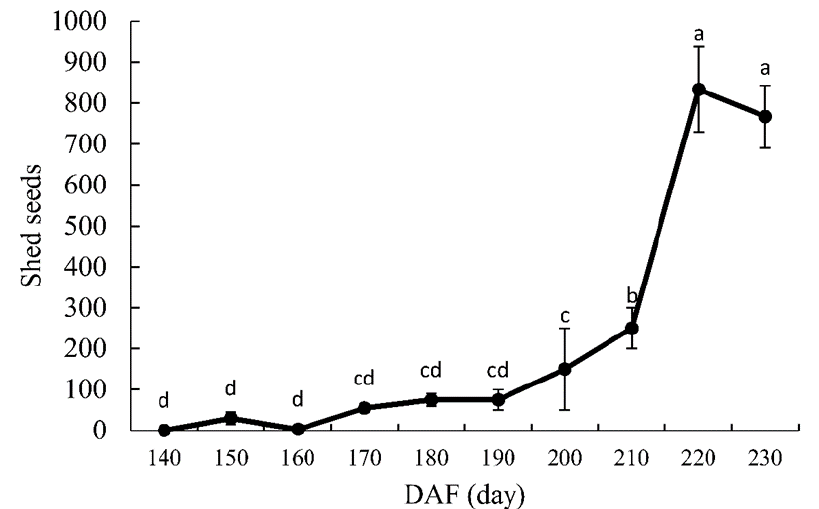
Figure 3. Number of seeds shed during the seed development of Ginkgo biloba ‘Jiafozhi’. Data are the mean ( ± SD) of three replicates, and bars labeled with the different lowercase letters are significant at p < 0.05.